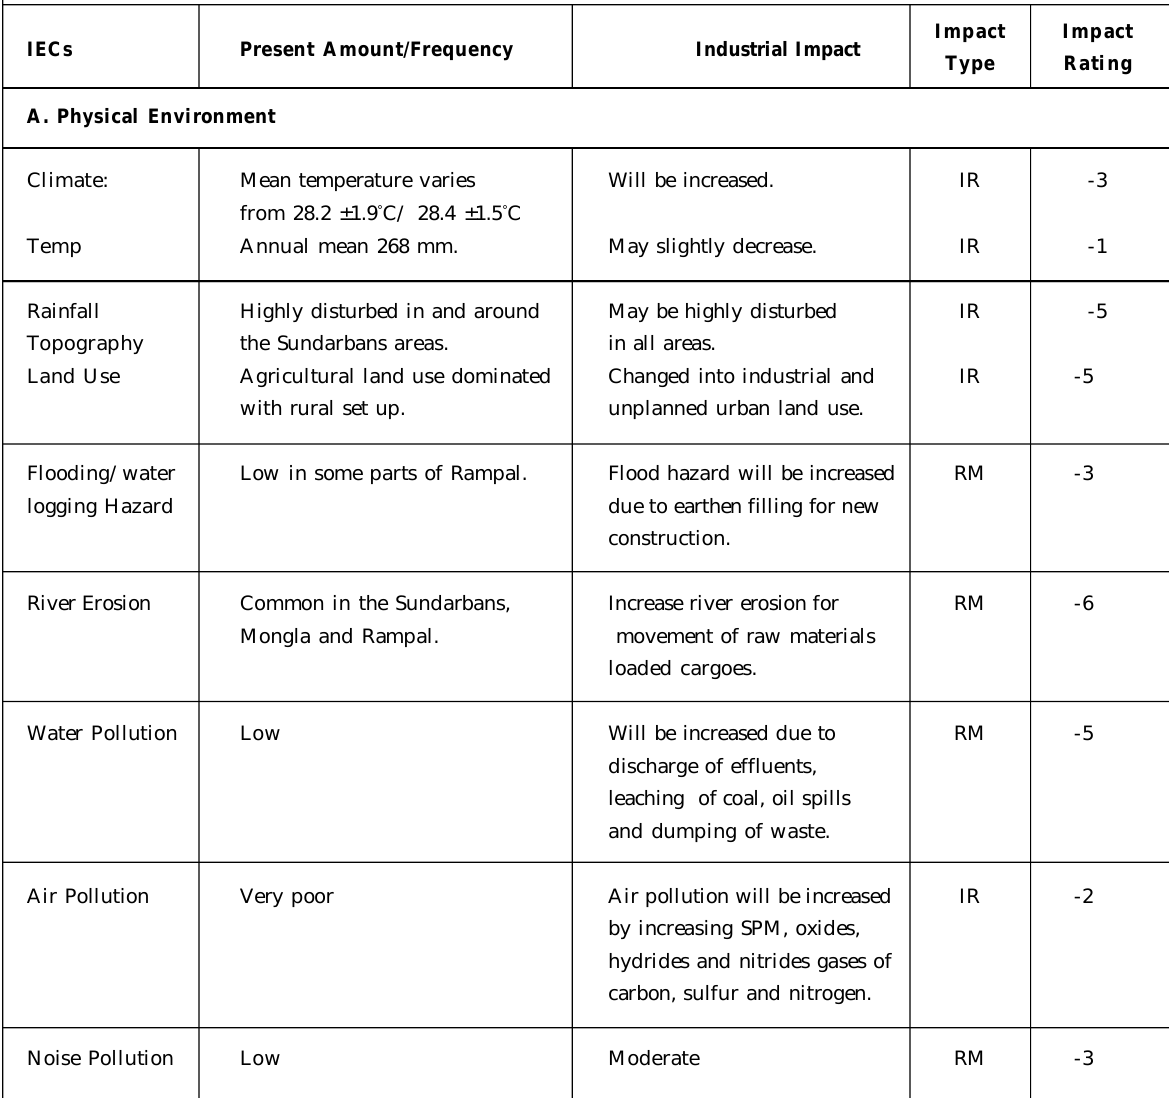
Table 7: Environmental Impact Assessment Matrix for industrialization on the periphery of the Sundarbans IECs Present